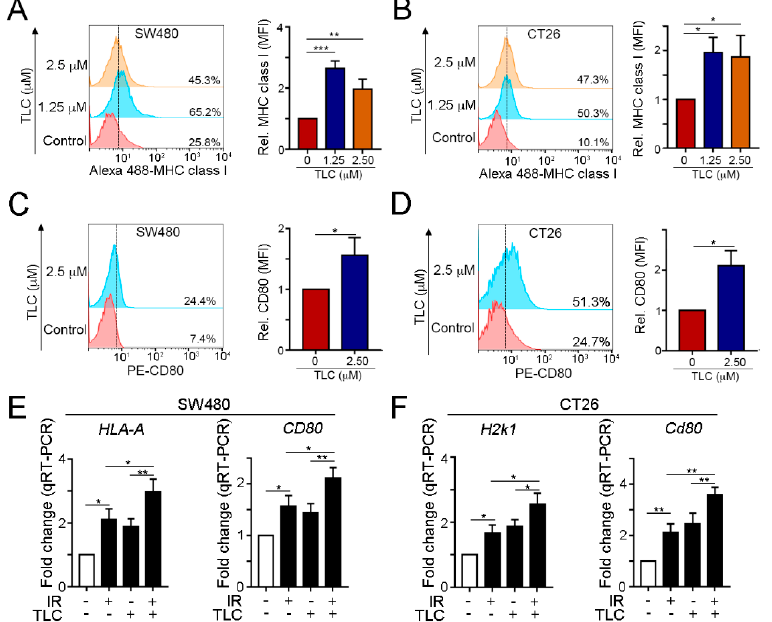
Figure 3. Lipotecan treatment triggered the immunogenicity of cancer cells. ( A ) SW480 cells were incubated with TLC for 24 h. The treated cells were harvested to examine the level of surface MHC class I was by flow cytometry. Quantification of these results is shown right ( n = 3, ** p < 0.01 and *** p < 0.001). ( B ) CT26 cells were treated with TLC for 24 h, and the level of surface MHC class I was examined by flow cytometry. Quantification of these results is shown right ( n = 3, * p < 0.05). ( C ) SW480 cells were treated with 2.5 µ M TLC for 24 h, and the level of surface CD80 was examined by flow cytometry ( n = 3, * p < 0.05.) ( D ) CT26 cells were treated with TLC for 24 h, and the level of surface CD80 was examined by flow cytometry. Quantification of these results is shown ( n = 3). * p < 0.05. ( E ) SW480 cells were treated with TLC (2.5 µ M) and IR (5 Gy) for 24 h, and the mRNA levels of HLA-A and CD80 were examined by qRT-PCR ( n = 3). * p < 0.05 and ** p < 0.01, ordinary